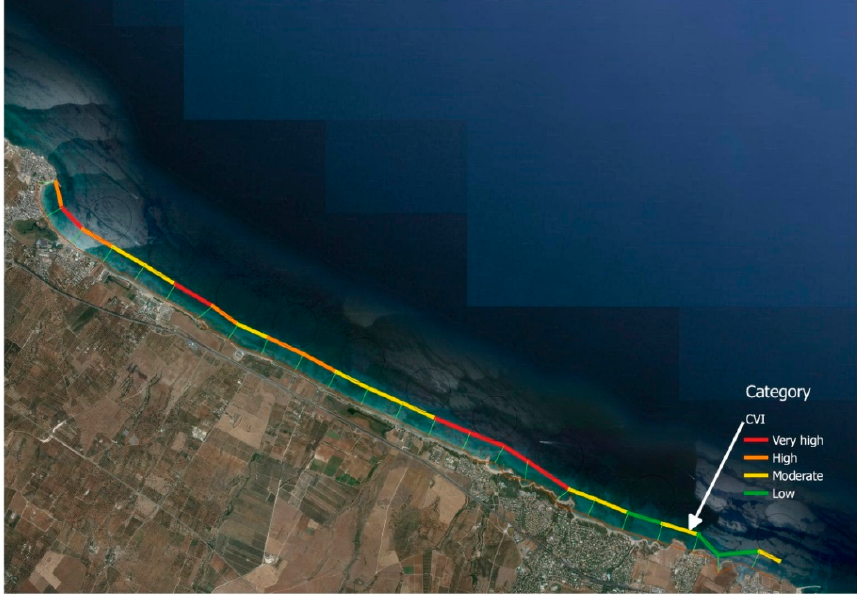
Figure 3. CVI value for each transect.